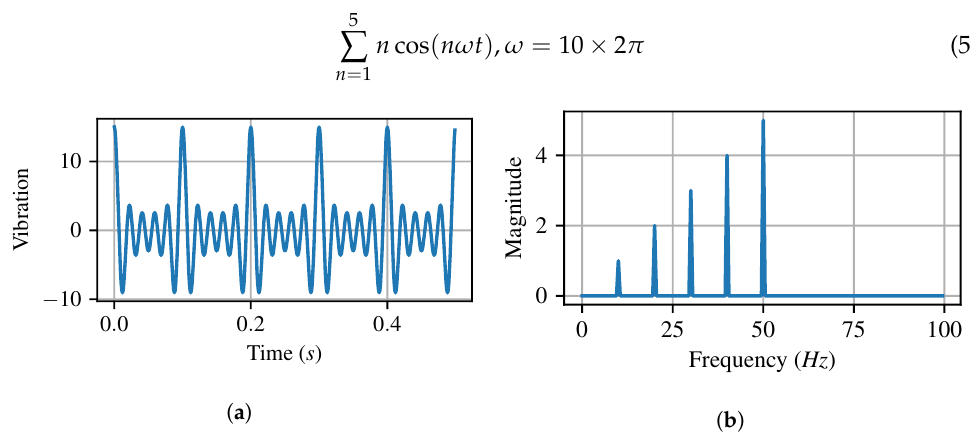
Figure 10. Different domain on the same wave. ( a ) Time domain; ( b ) Frequency domain.